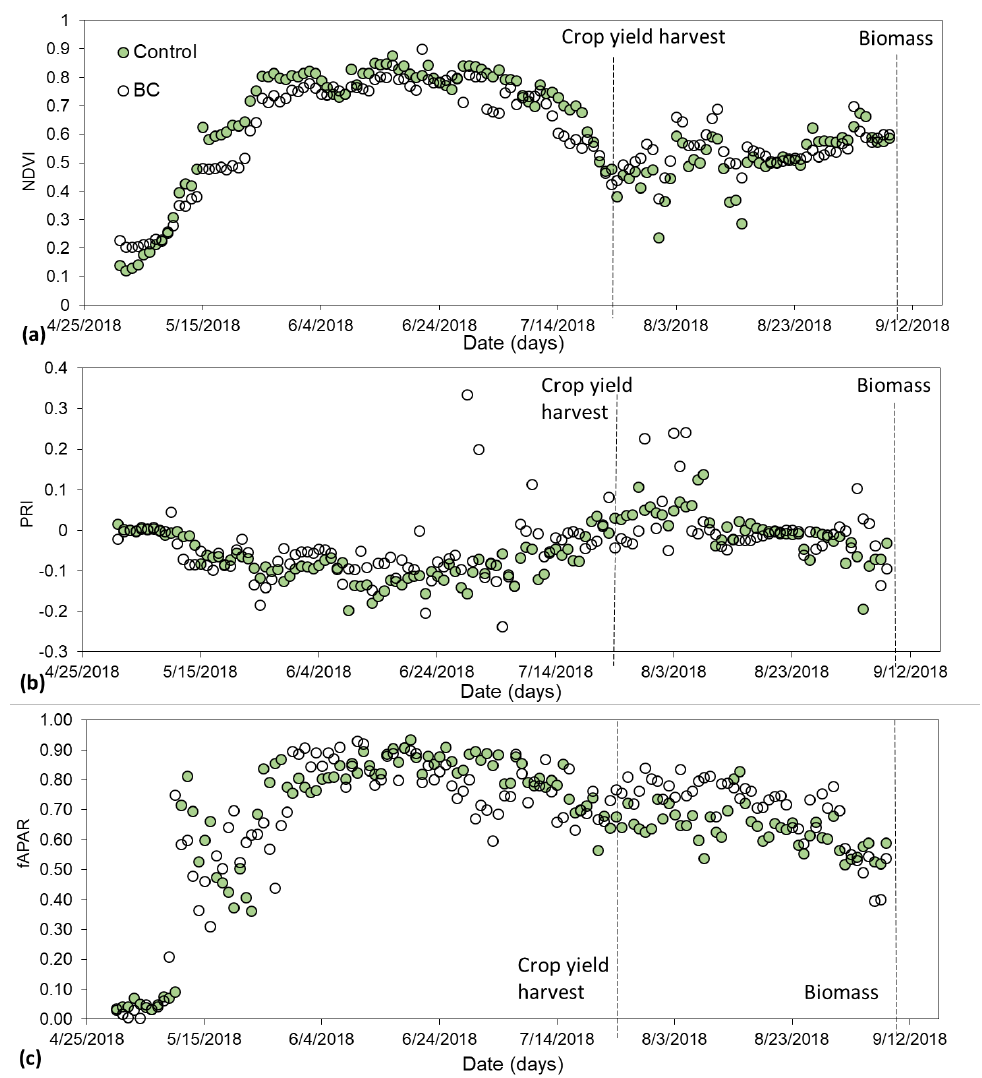
Figure 3. Average midday values of ( a ) normalized difference vegetation index (NDVI), ( b ) photochemical reflectance index (PRI), and ( c ) fraction of absorbed photosynthetically active radiation (fAPAR) data for the control and biochar (BC) treatments during vegetation growth in 2018. Dotted lines represent the times of crop yield and biomass harvests.